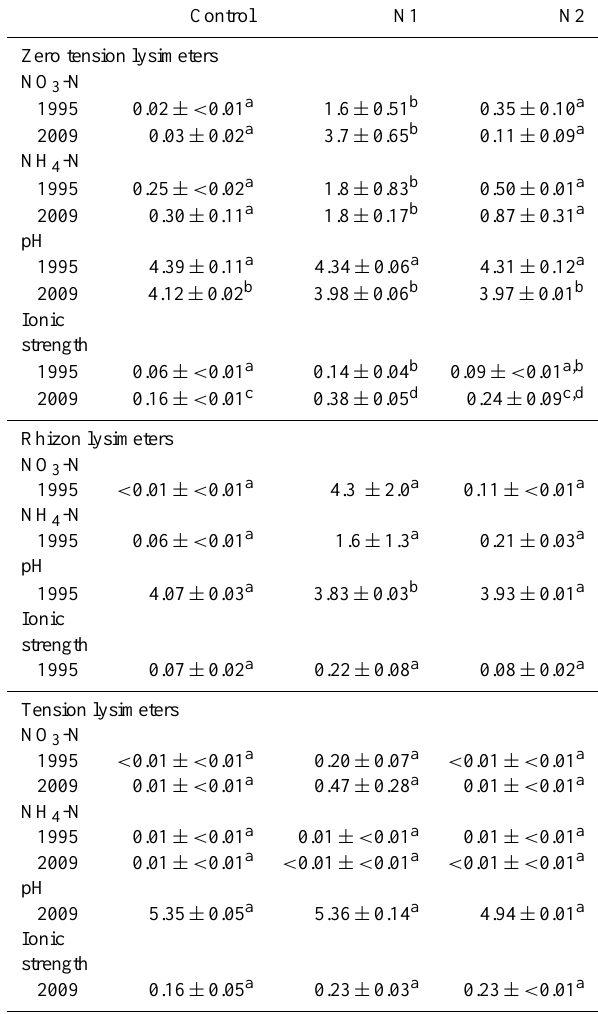
Table 7. Nitrate (NO 3 ), ammonium (NH 4 ) both in mgNL − 1 , pH and ionic strength (mmolL − 1 ) at Str˚asan in 1995 and 2009. Values are mean ± range ( n = 2). Superscripts ( a , b , c and d ) denote signif- icant differences at P = 0 . 05 (Tukey HSD test). Within lysimeter type and variable, means lacking a common superscript